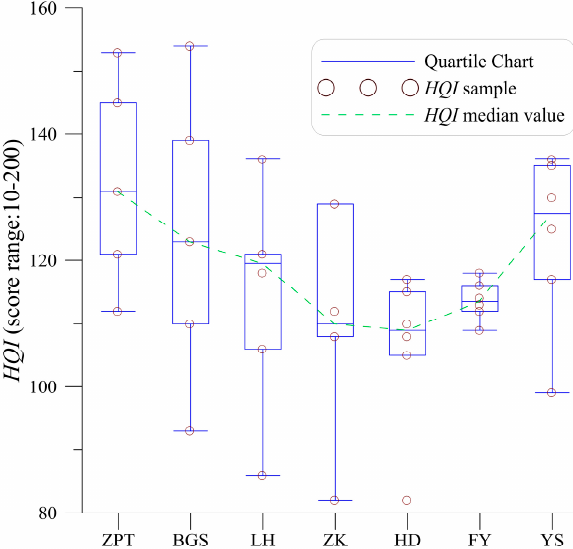
Figure 5. The assessment results of the habitat quality index ( HQI ).